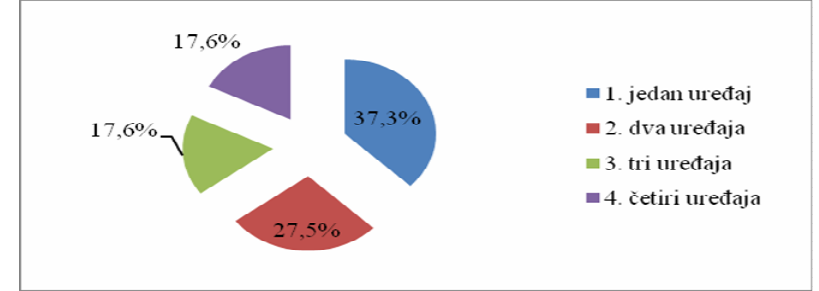
Prikaz 2 . Broj uređaja za pristup internetu koje ispitanici poseduju Uprkos tome što najveći broj ispitanika poseduje samo jedan uređaj pomoću koga pristupa internetu, broj onih koji imaju više ovakvih uređaja je daleko od zanemarljivog. Jasno je da je učenicima dostupnost ovog medija važna što je, opet, sasvim u skladu sa prethodno navedenim nalazima (Prikaz 1) i stavovima pomenutih autora, dok korišćenje većeg broja uređaja različite vrste (i stepena mobilnosti) nesumnjivo čini da je internet učenicima mnogo dostupniji. Da je ovo (dostupnost) za učenike zaista važno svojstvo, donekle potvrđuju i odgovori koje su dali na pitanje koji od navedenih uređaja najčešće koriste (Prikaz 3).